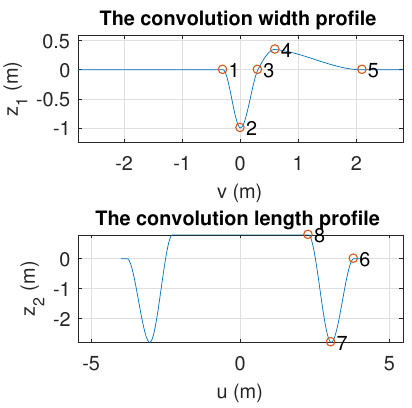
Figure A2. The shape of the convolution filter. Top : The left rut profile construction. Bottom : The length profile construction. See also Figure 8 for the general